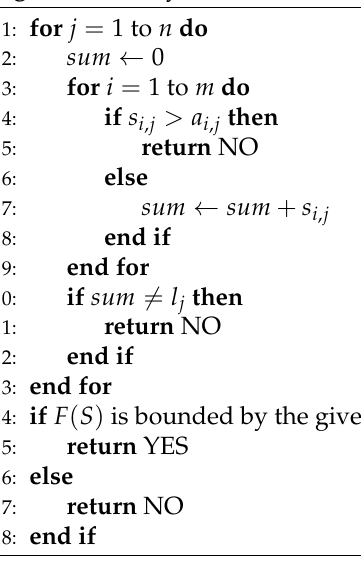
Algorithm 2 Polynomial certificate verification.